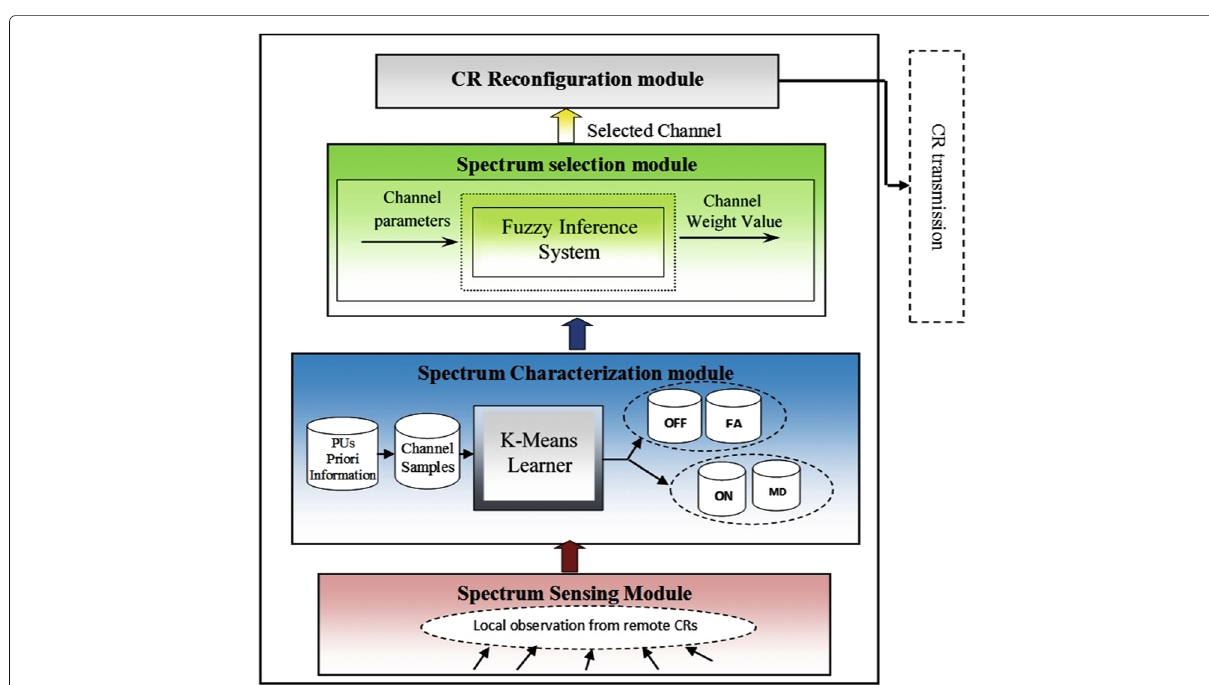
Fig. 1 ILFCS channel selection framework. The proposed channel selection framework modules is illustrated